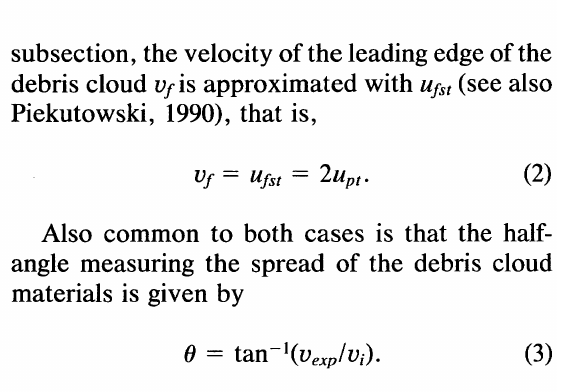
FIGURE 4 Debris cloud